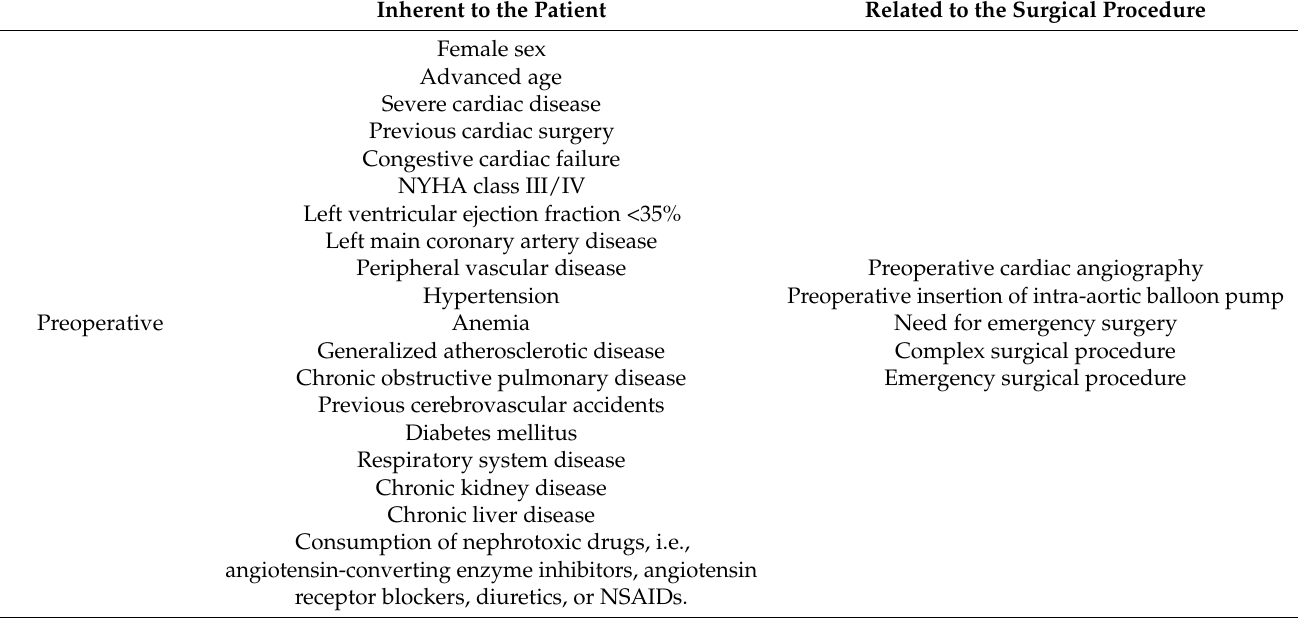
Table 1. Primary risk factors for CSA-AKI. CPB, cardiopulmonary bypass; NSAID,